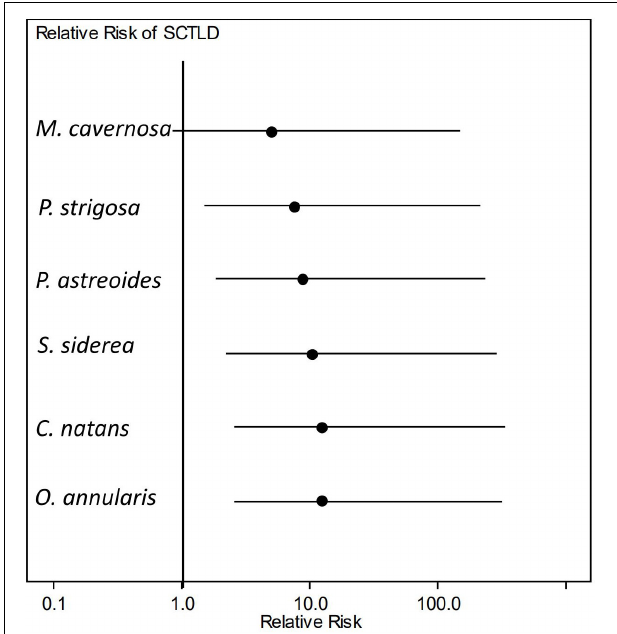
FIGURE 5 | Relative risk of stony coral tissue loss disease (SCTLD) incidence. Dots represent the median and lines represent the credible intervals for relative risk of developing lesions consistent with SCTLD after exposure to a diseased coral. Only Montastraea cavernosa showed no significant elevated risk of SCTLD-type lesion development when compared with controls.